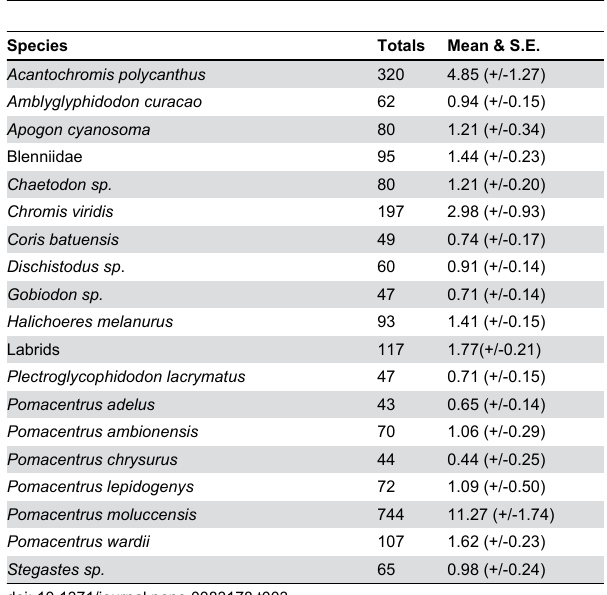
Table 3. Total abundance of fish species used in forward DistLM and dbRDA